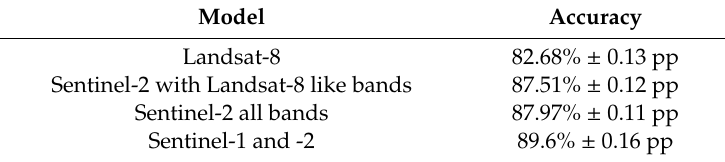
Table 5. Accuracy of each model in separating forest types in the Bago Yoma of